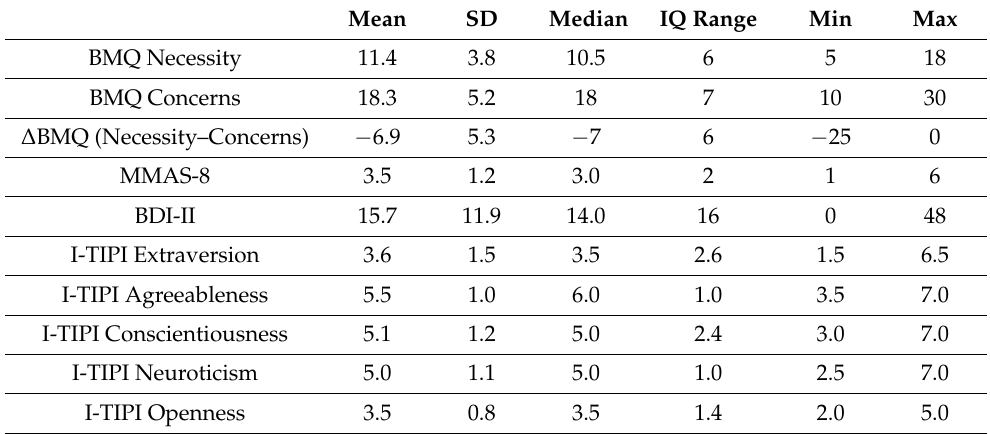
Table 2. Descriptive statistics of the BMQ, MMAS-8, BDI-II, and I-TIPI scores.